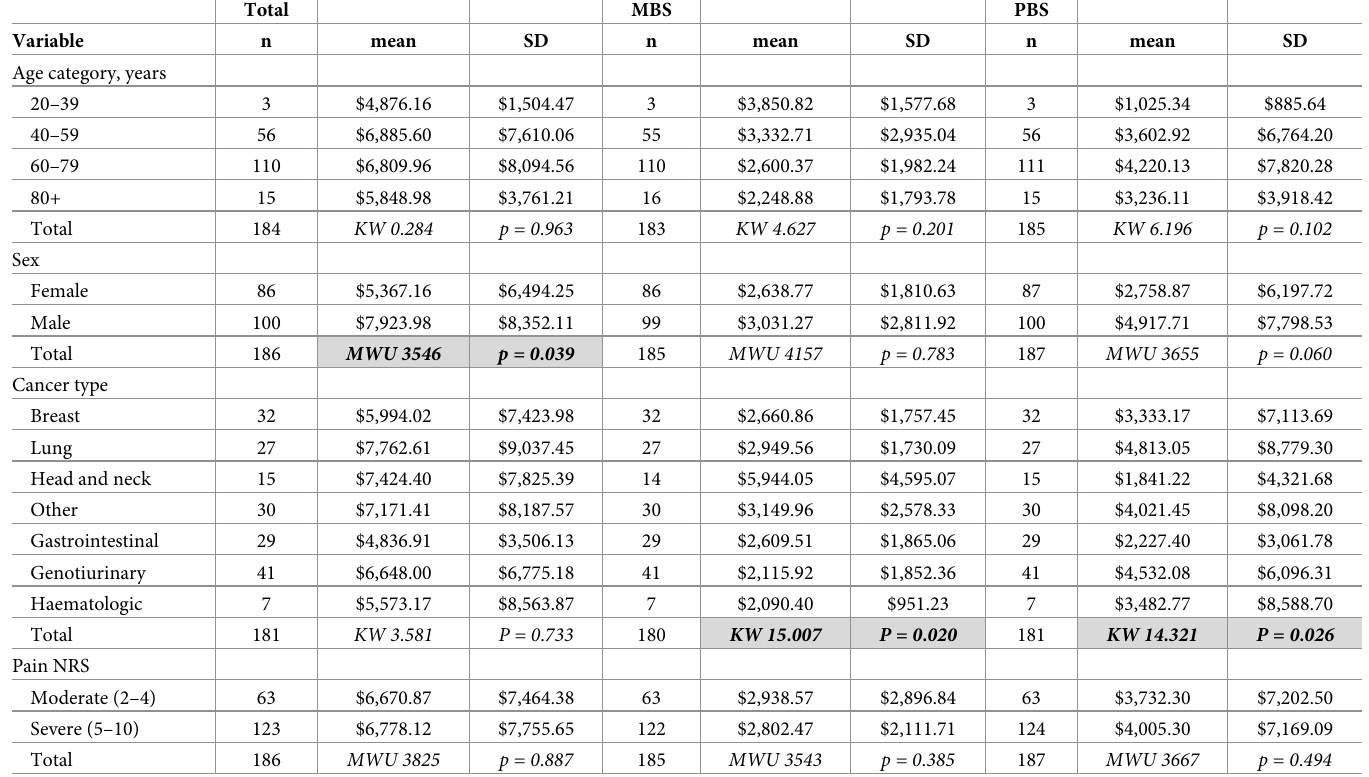
Table 5. Unadjusted, mean healthcare costs by clinico-demographic